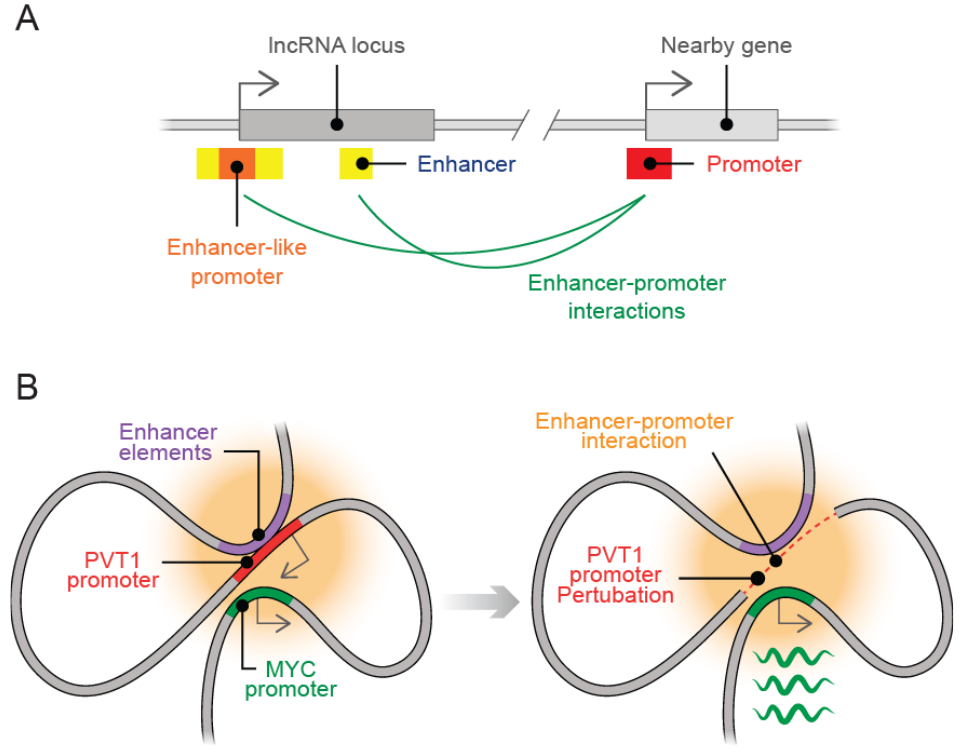
Figure 2. Regulatory elements within lncRNA loci influence local gene regulation. ( A ) Promoters with enhancer-like activity and enhancer elements embedded in a particular lncRNA locus can induce a regulatory effect at distant genes. In some cases, neither the act of transcription nor the RNA transcript is necessary to distal gene regulation by the regulatory element. ( B ) LncRNA promoters can function as boundary elements to limit gene regulation by distal regulatory elements such as enhancers. PVT1 promoter prevents enhancer-promoter communication between intragenic enhancers within PVT1 lncRNA and MYC promoter. PVT1 promoter inactivation or mutation enables enhancer-promoter interactions and subsequent MYC overexpression.